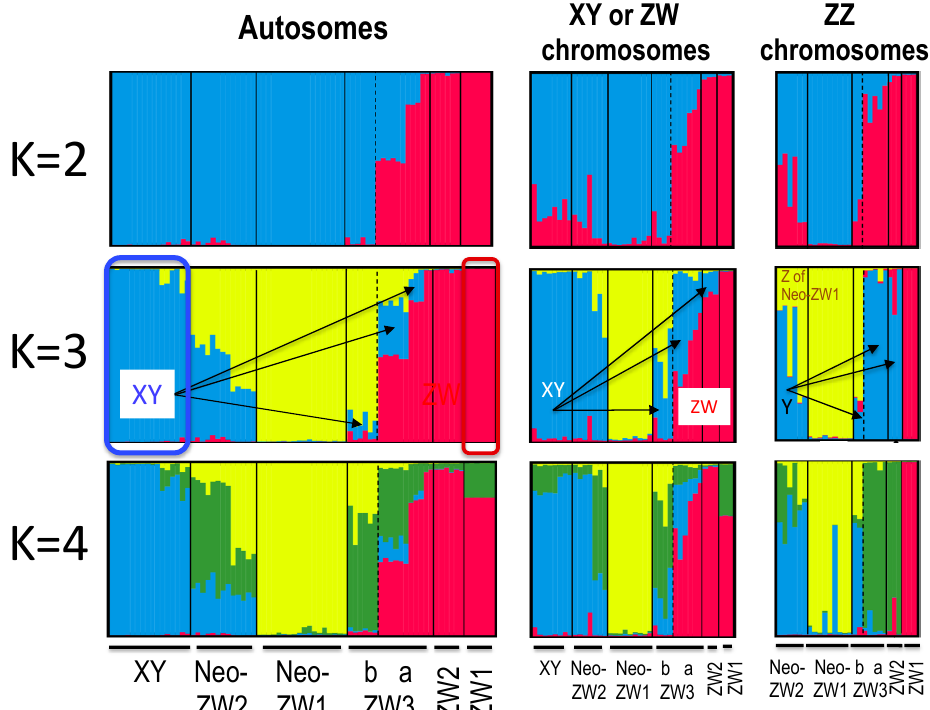
Figure 4. Histograms of STRUCTURE assignment test for autosomal 1626 SNPs and 220 sex-linked SNPs. K values (No. of clusters) are 2, 3 and 4. The populations used for the analysis and their locations are shown in Table 1 and Figure 1. The sex-linked SNPs of heterogametic XY males and ZW females were used for investigating genomic structures of ZW and XY chromosomes, while homogametic ZZ males were used for those of Z chromosomes. Arrows indicate introgressions of genomes from XY group to ZW group. Clusters of XY group and ZW1 sub-group are boxed in K = 3 map (autosomes).